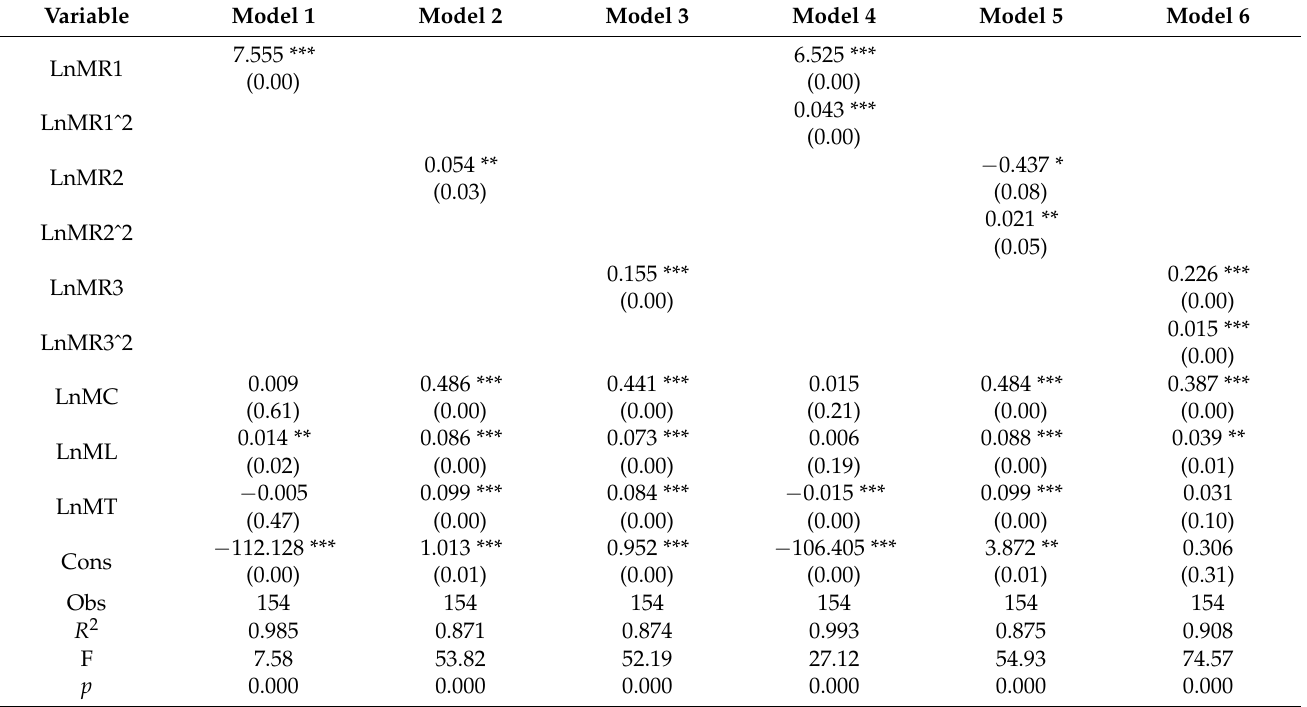
Table 3. Test results of the relationship between marine resources and economic growth (explained variable: marine economic